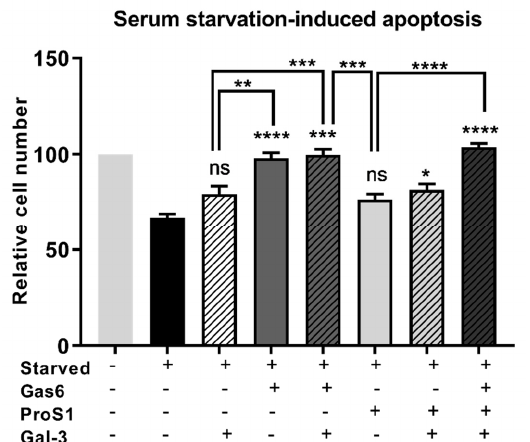
Figure 6. MTS assay of survival of SCC-25 cells treated with Gas6, ProS1 or Gal-3 separately or jointly in a serum-free medium to trigger apoptosis by prolonged serum starvation over 15 days. Data are the mean ± SEM and underwent ANOVA with Tukey’s multiple comparison post-hoc analysis; **** p < 0.0001, *** p < 0.001, ** p < 0.01, * p < 0.05 vs. untreated starved cells or for comparisons Biomolecules 2020 , 10 , x indicated by lines ( n = 4 experiments).